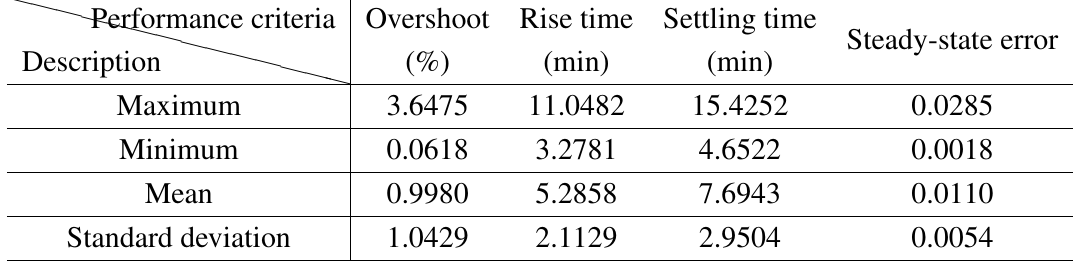
Table 3. The corresponding performance criteria (mean of two